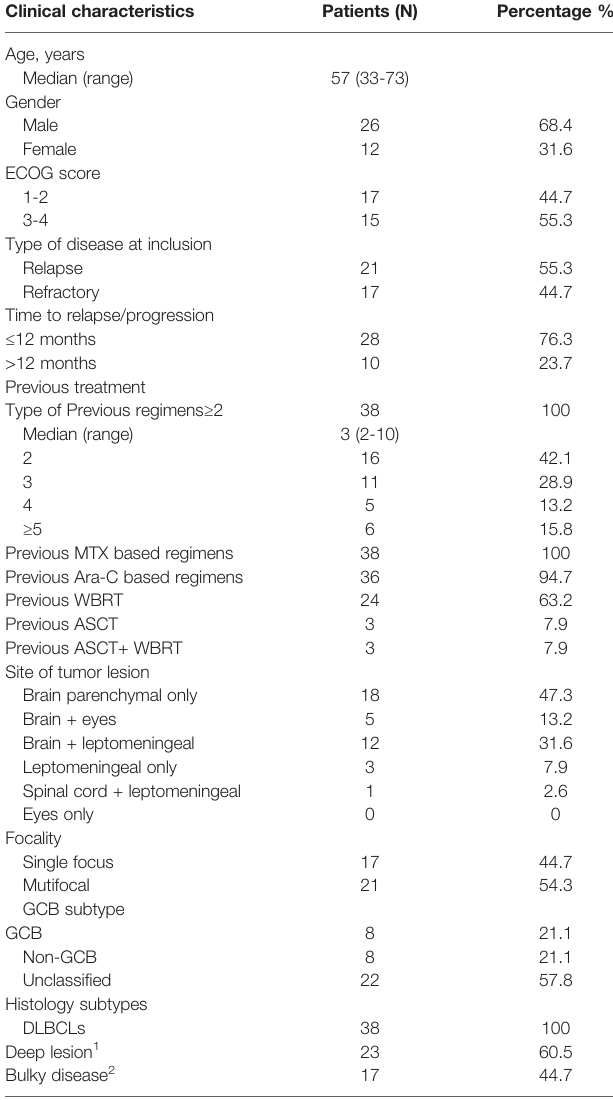
TABLE 1 | Baseline characteristics of all patients (N = 38). Clinical characteristics Patients